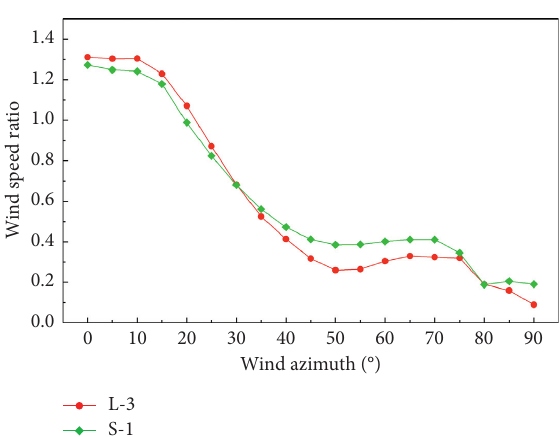
Figure 24: The variation of the wind speed ratio in the models of L- 3 and S-1 with the wind